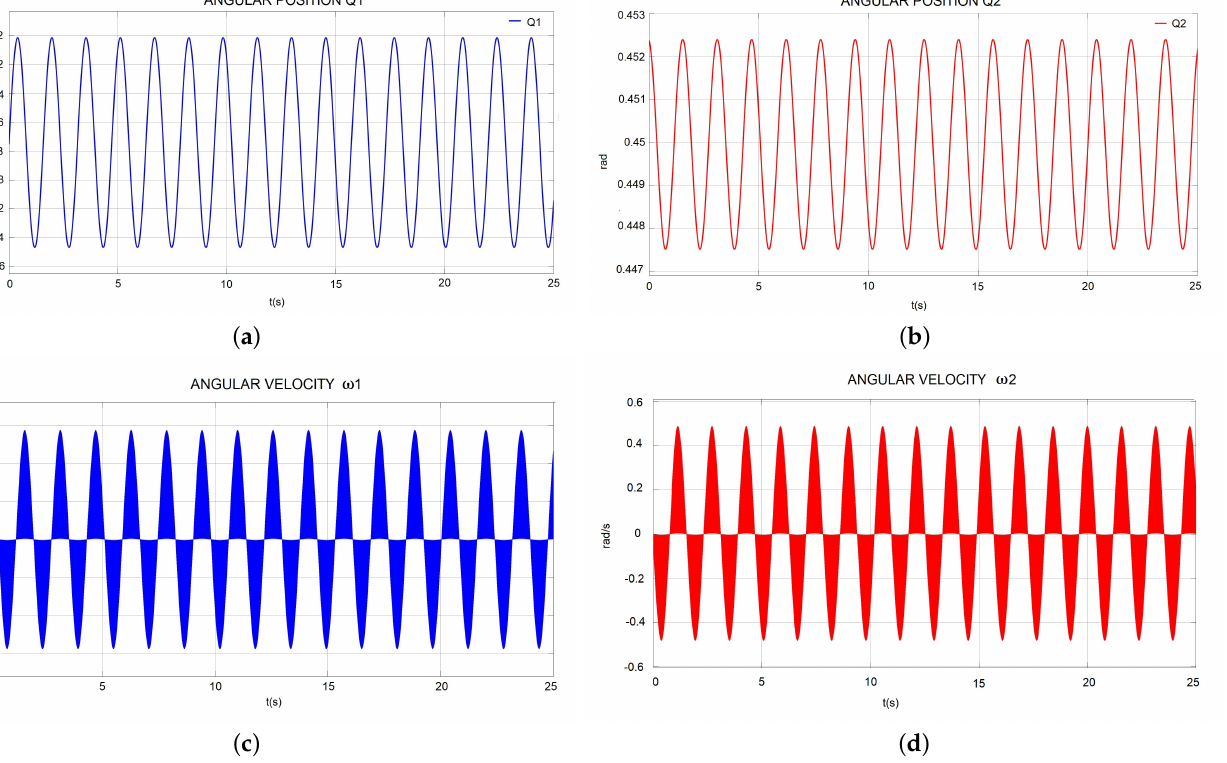
Figure 8. ( a ) Angular position Q 1 . ( b ) Angular position Q 2 . ( c ) Angular velocity ω 1 . ( d ) Angular velocity ω 2